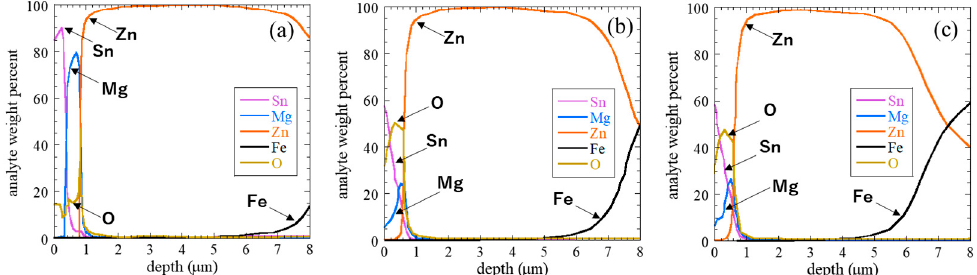
Figure 3. GD-OES depth profile for Sn/Mg films as a parameter of heat treatment. ( a ) As coated, ( b ) 190 °C for 30 min, and ( c ) 220 °C for 30 min.